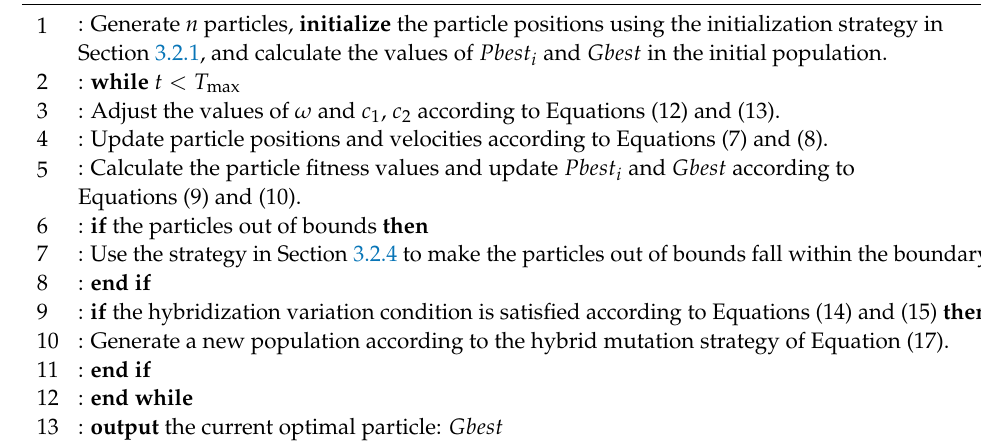
Algorithm 1: Multi-Strategy Hybrid Particle Swarm Optimization Algorithm